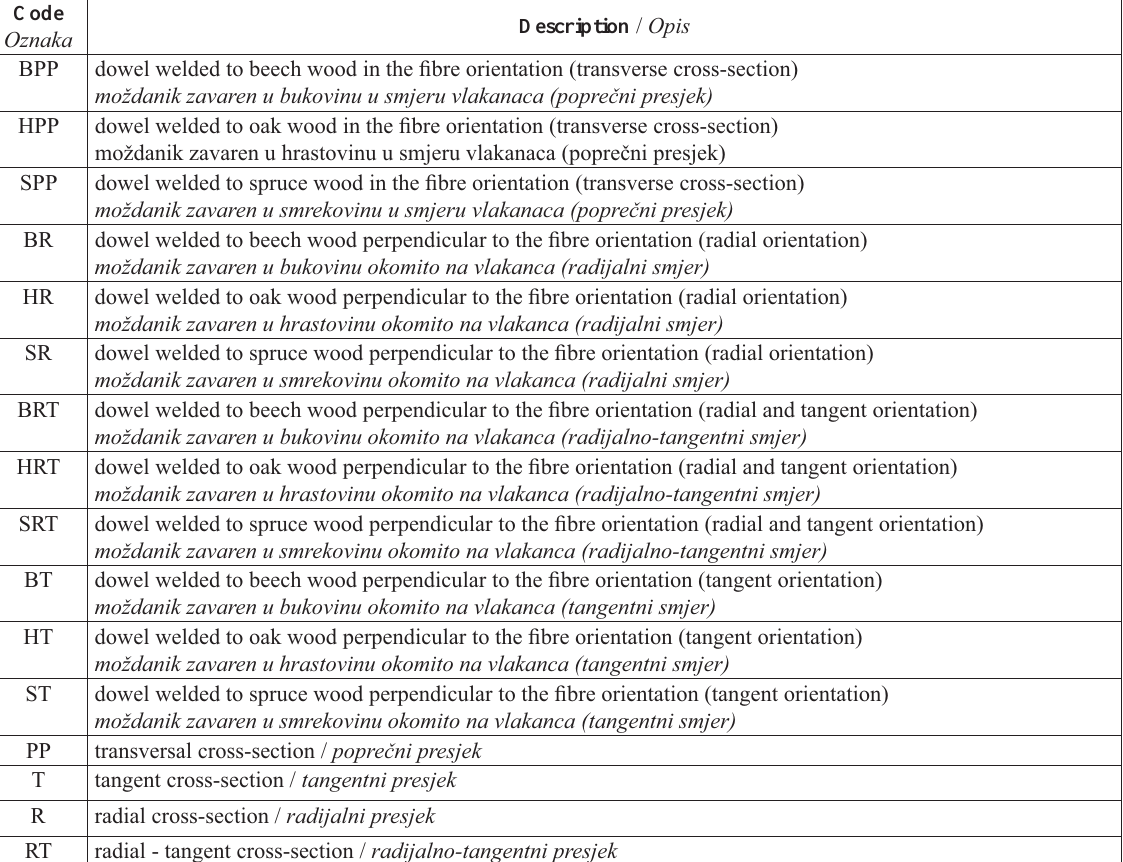
Table 1 Samples used in the research Tablica 1. Uzorci rabljeni u istraživanju